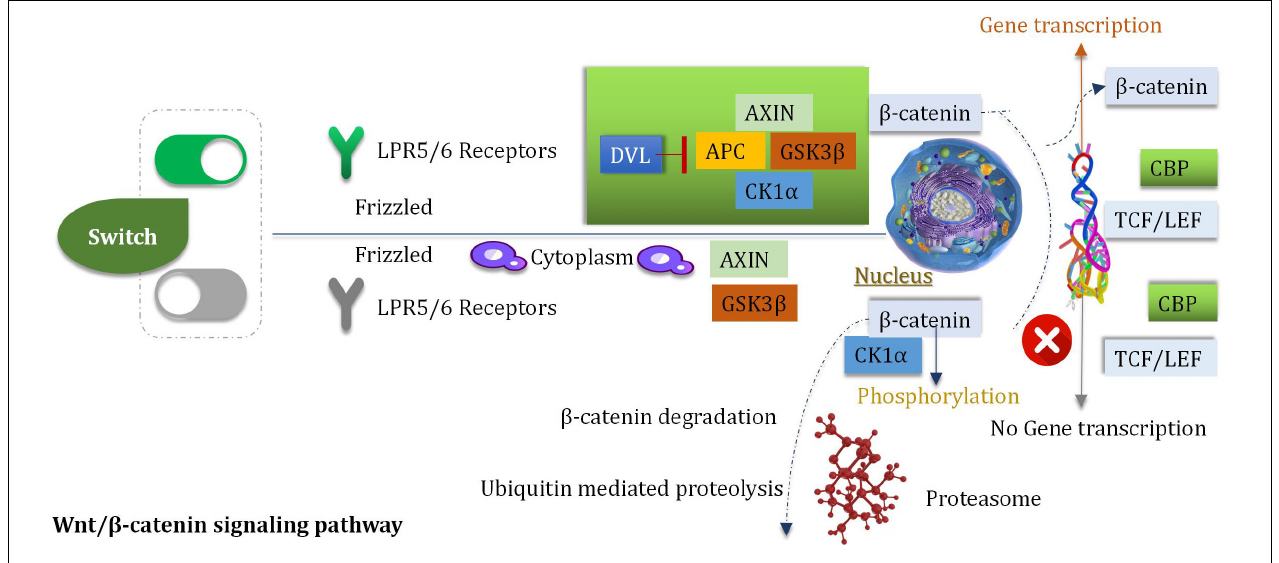
FIGURE 6 | On/OFF WNT/ β -catenin signal